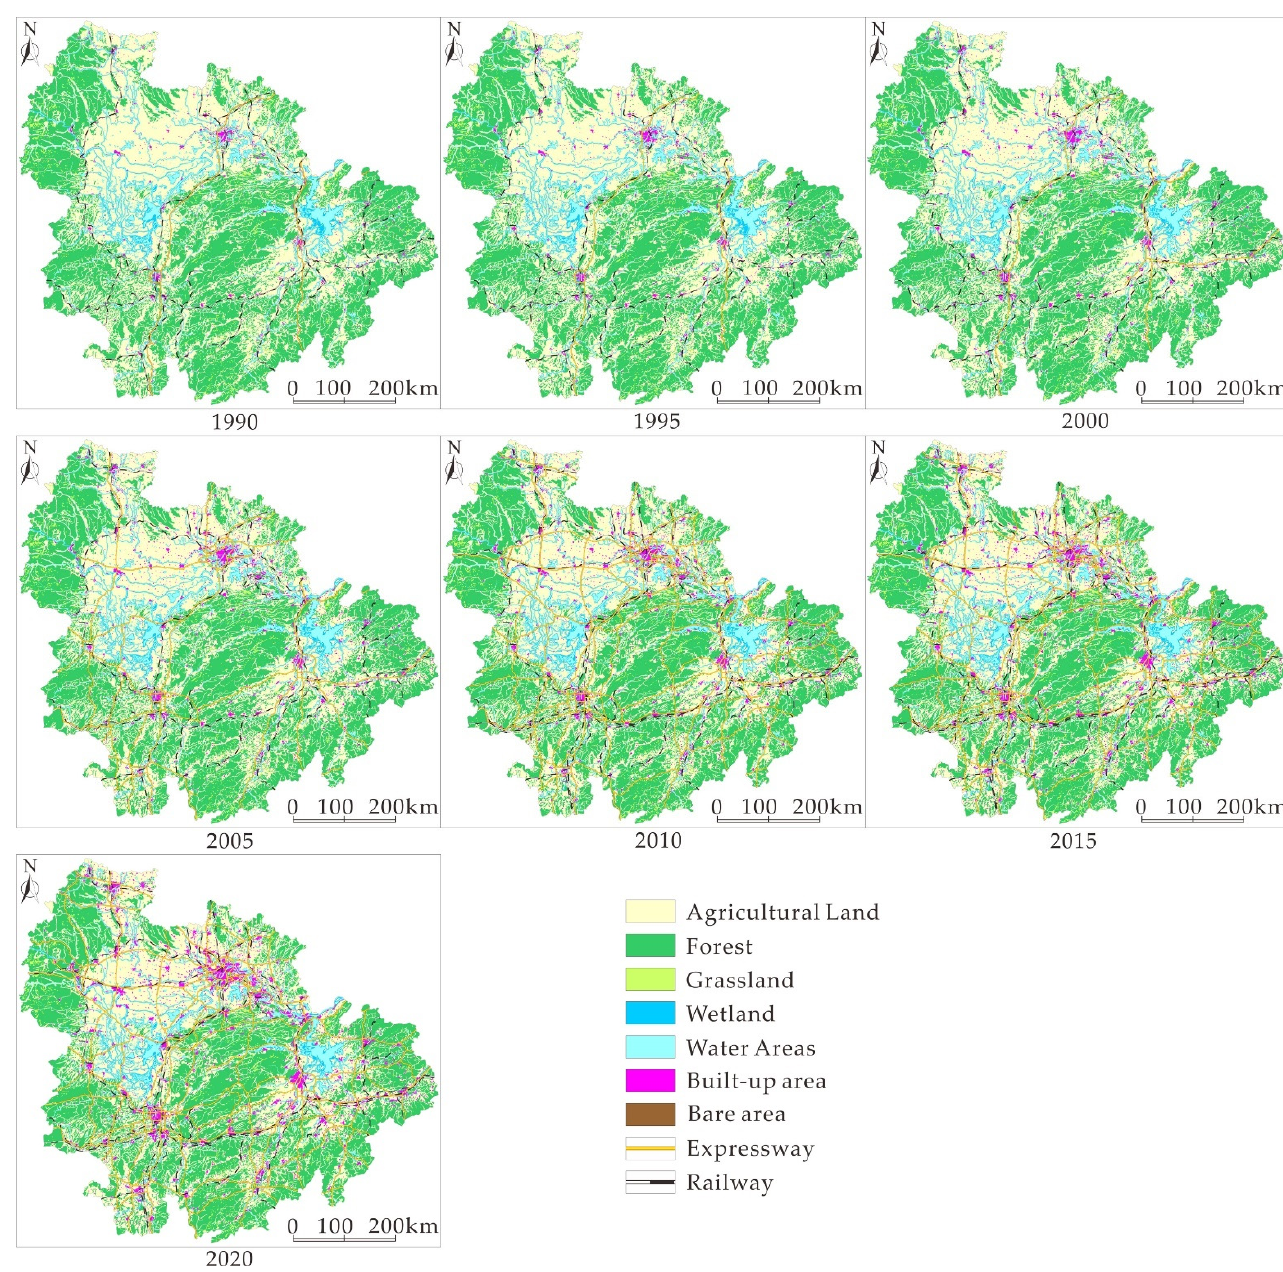
Figure 3. Landcover change in UAMRYR (1990–2020).